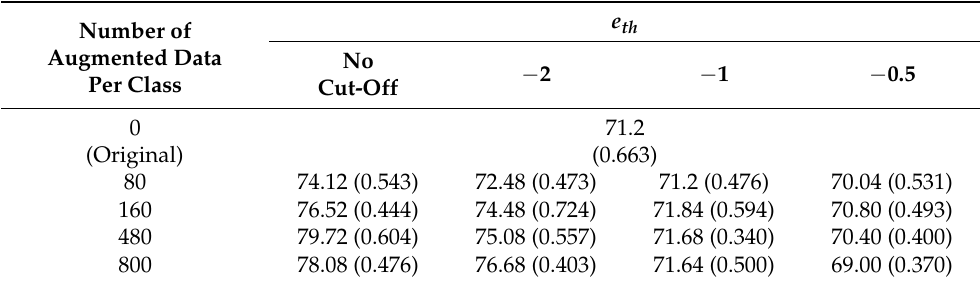
Table 1. Effects of data cut-off on classification accuracy. The GNDv2 with κ = 0.5 was used. The numbers in parentheses represent the standard